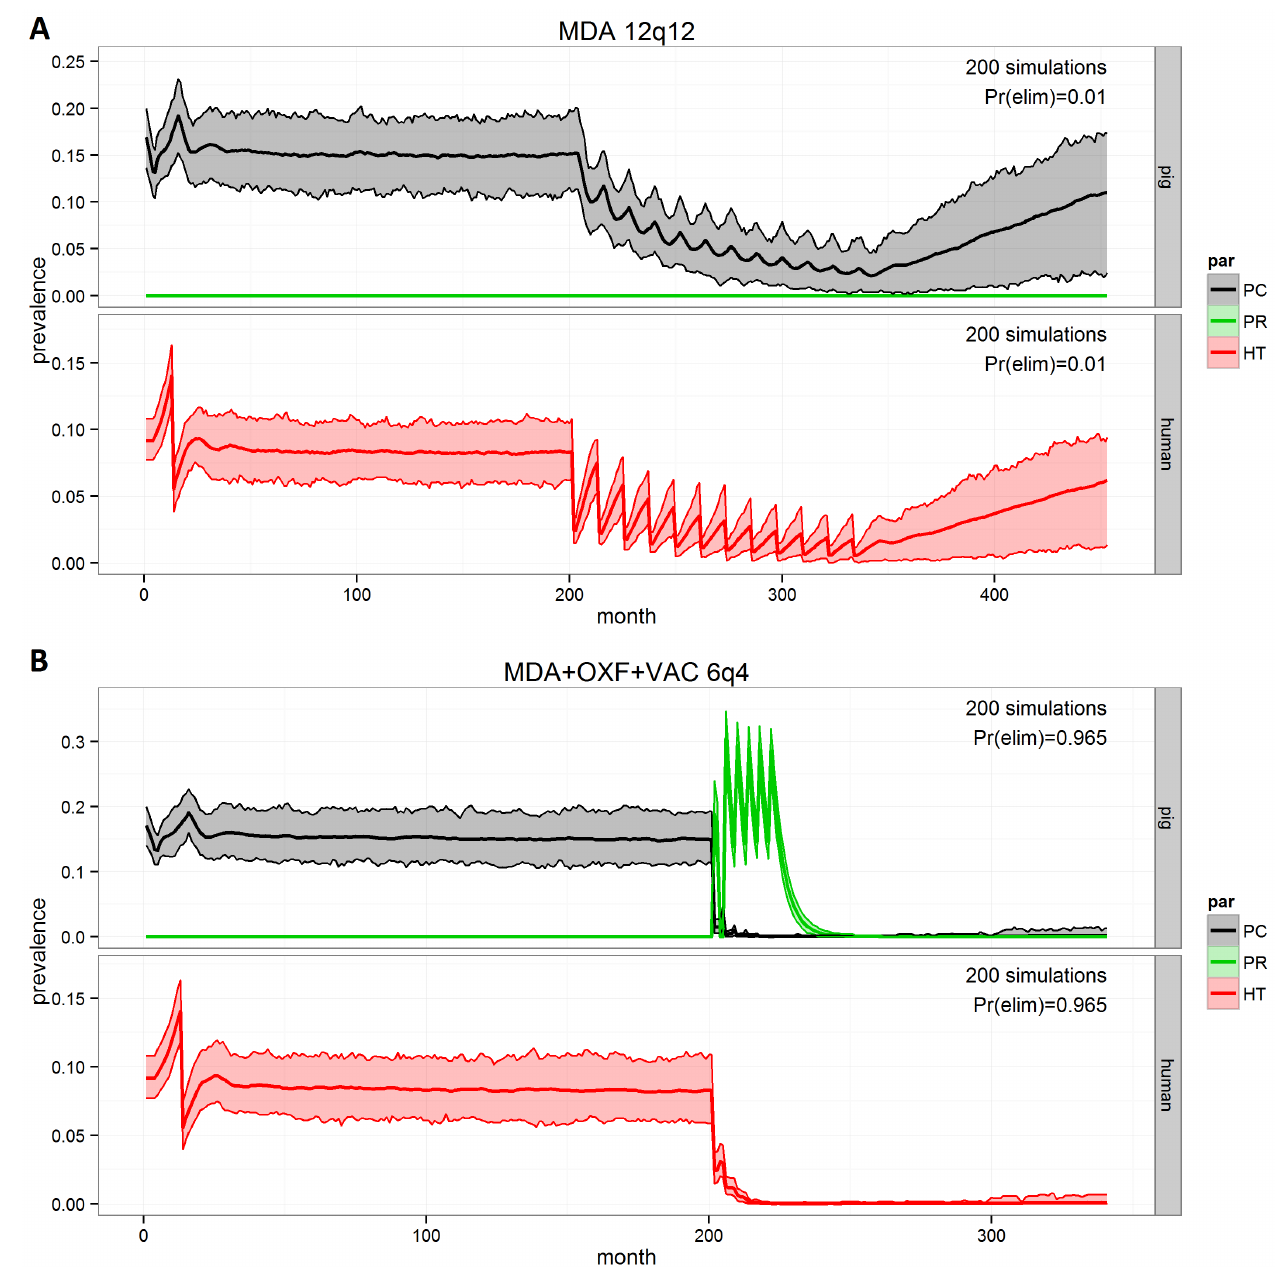
Figure 3. cystiSim output for different intervention scenarios aiming for control and elimination of Taenia solium in Zambia. Interventions aiming for control ( A ) and elimination ( B ): Pr : probability of elimination of transmission (EOT) of porcine cysticercosis (PCC) (elim) and human taeniasis (HT), MDA: human mass drug administration (praziquantel), OXF: porcine mass drug administration (oxfendazole), VAC: porcine vaccination (TSOL18), XqY: total number of X iterations of the intervention given at intervals of Y months. Interventions are